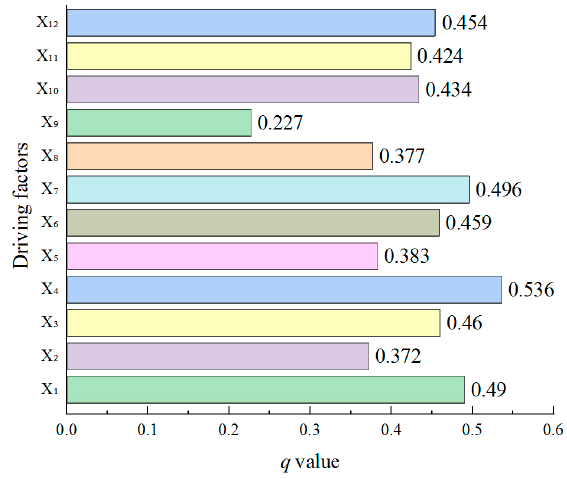
Figure 6. Q statistics for factor probes.